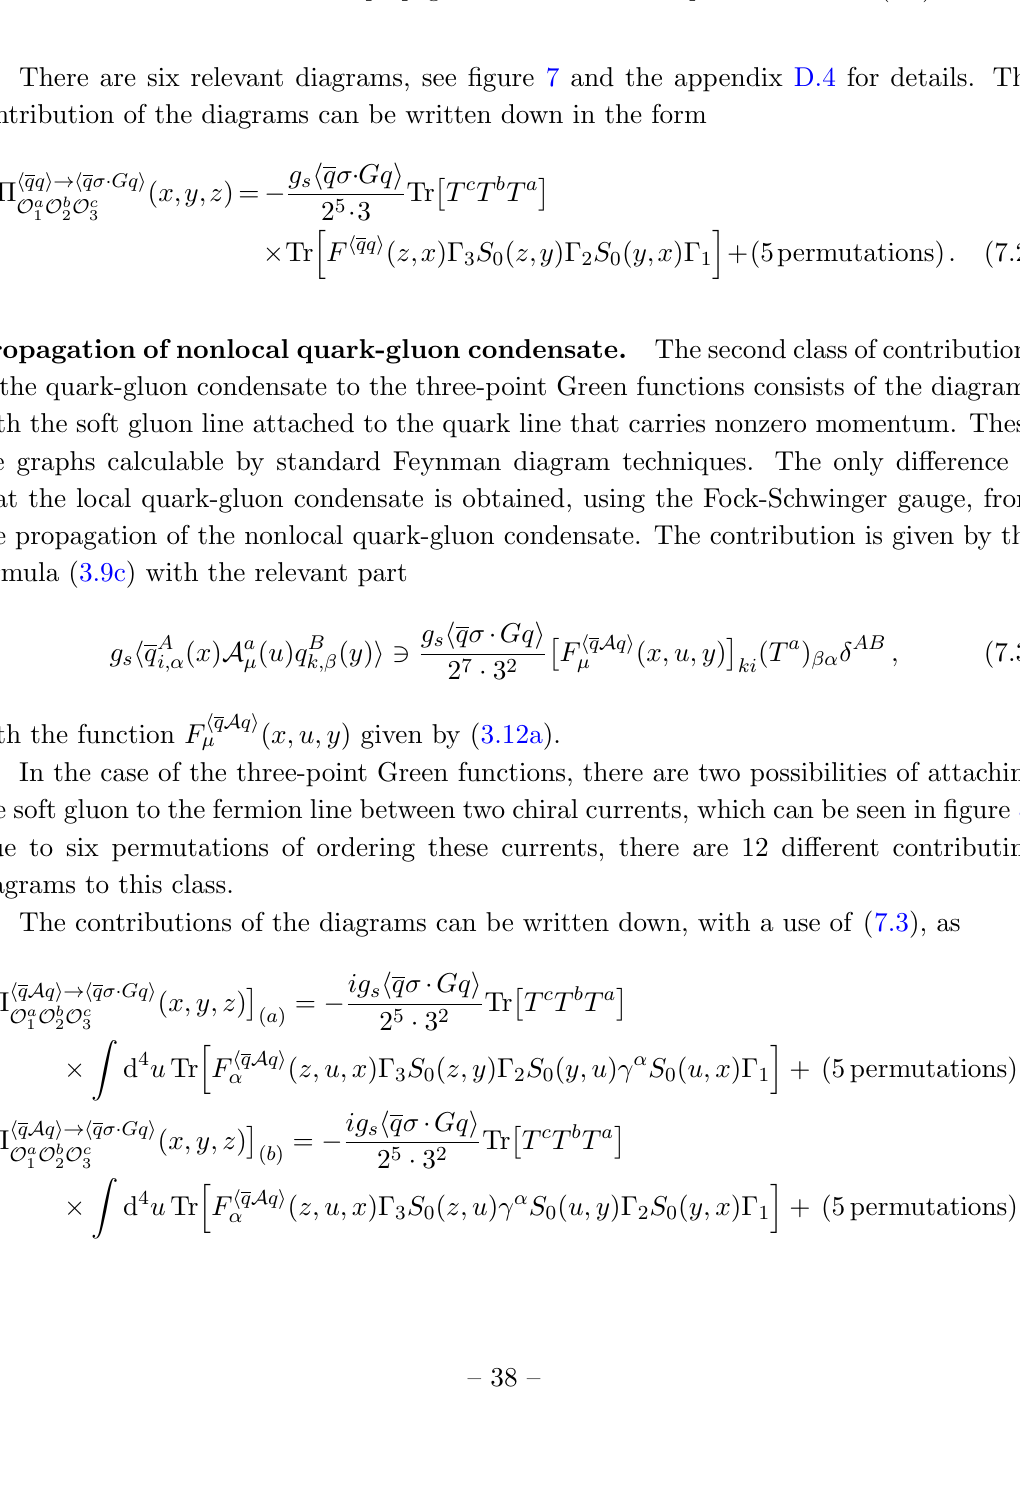
Figure 7. Feynman diagrams of the contributions of the quark-gluon condensate to the three-point Green functions due to the e(cid:11)ective propagation of the non-local quark condensate